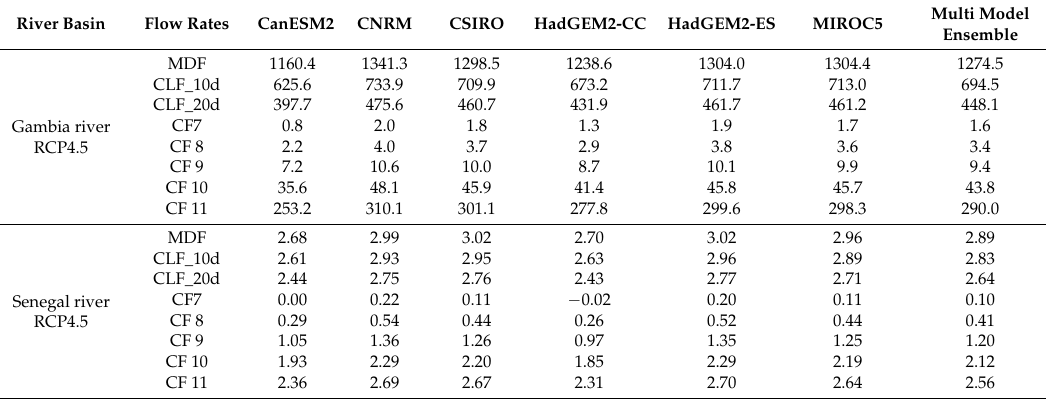
Table A3. Relative change in flows below the median for different chosen GCM under